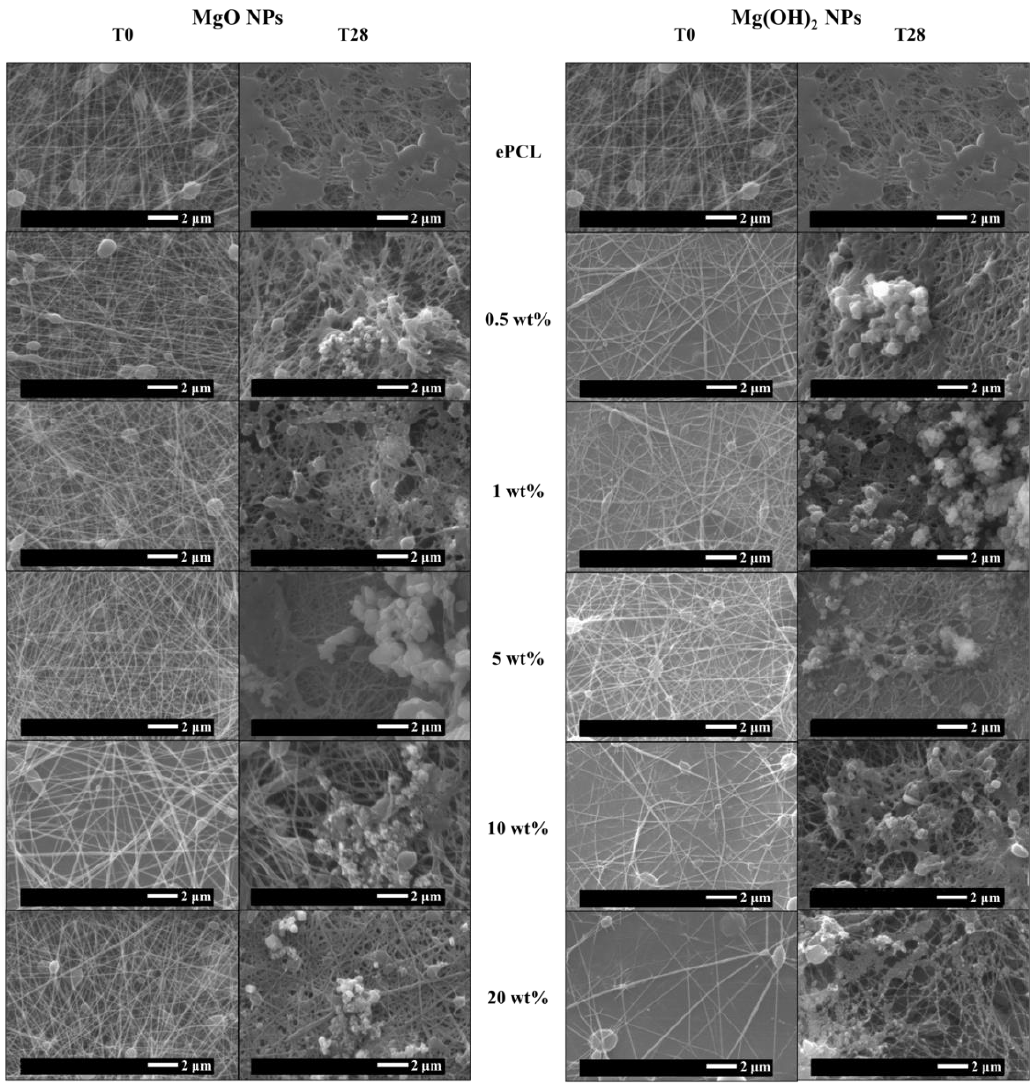
Figure 11. SEM images of ePCL + MgO and Mg(OH) 2 at T0 and after 28 days of immersion in SBF. Once the morphology of the electrospun nanofibers had been studied, the materials were characterized by an EDX analysis. In order to determine the presence of hydroxyap- atite, the calcium/phosphate (Ca/P) ratios were calculated and summarized in Table 2. Only the systems reinforced with 20 wt% of NPs showed the highest values of the Ca/P ratio; therefore, as an example, the EDX analysis of nanofibers with 20 wt% of NPs is re- ported in Figure 12. Table 2. Calculated Ca/P ratio values of ePCL, ePCL + MgO NPs and ePCL + Mg(OH) 2 NPs at T0 and after 28 days of immersion in SBF.